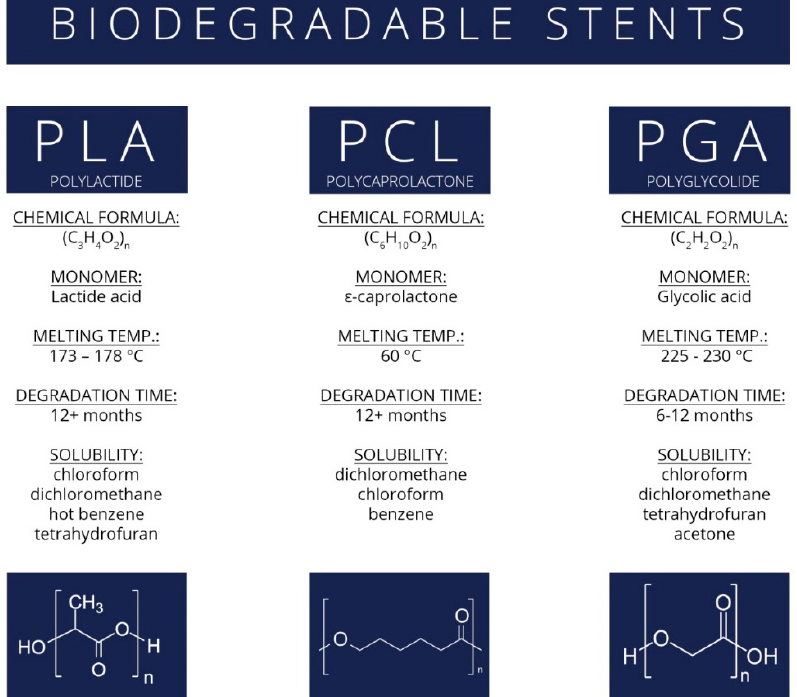
Figure 8. Poly(L-lactic acid) (PLLA) and poly(D-lactic acid) (PDLA) forms of polylactic acid (PLA). PLA has good mechanical properties, such as transparency, high strength, and biodegradability [136–138]. The mechanical properties of PLA may vary depending on various parameters such as crystallinity, molecular weight, material formulation (plasticizers, blends, composites, etc.) and processing. The resulting polymer may range from soft and elastic materials to stiff and